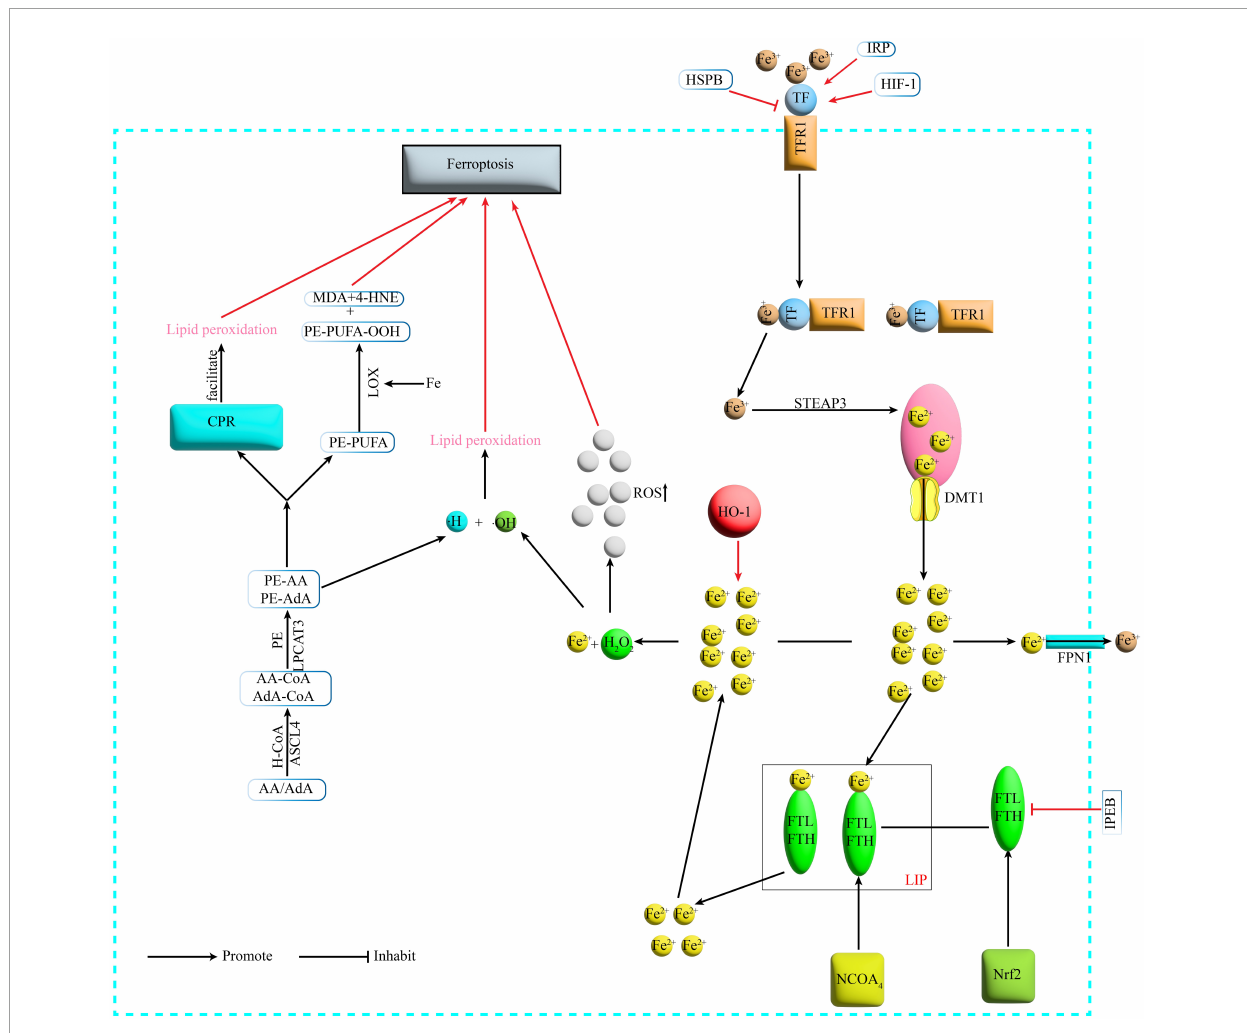
FIGURE1 Mechanism of Ferroptosis. Fe 3 + binds to TF on the cell membrane and is transported via TFR1 on the cell membrane surface, and the TFR1-TF-Fe 3 + complex enters the cell by endocytosis. Under acidic conditions, Fe 3 + is released from the binding and reduced by STEAP3 to Fe 2 + , which then enters the cytoplasm via DMT1 from the endosome. In the cytoplasm Fe 2 + is partly transported outside the cell and converted to Fe 3 + by FPN1, partly bound to ferritin to form LIP, and NCOA4 can recognize and rely on the autophagic pathway to degrade ferritin in the iron pool, releasing large amounts of Fe 2 + . TF, transferrin; TFR1, transferrin receptor1; STEAP3, six-transmembrane epithelial antigen of prostate 3; DMT1, divalent metal transporter 1; FPN1, membrane iron transporter 1; FPN1, ferroportin1; FTL, ferritin light chain; FTH, ferritin heavy chain; LIP, labile iron pool; NCOA4, nuclear receptor coactivator 4; H 2 O 2 , hydrogen peroxide; ACSL4, acyl-CoA synthetase long-chain family member 4; LPCAT3, lyso-phosphatidylcholine acyltransferase-3; LOX, lipoxygenase; MDA, malondialdehyde; 4-HNE, 4-hydroxynonenal; POR, cytochrome P450 oxidoreductase; IREB2, iron-responsive element-binding protein 2; HSPB1, heat shock protein beta-1; IRP, iron- regulatory protein; HIF-1, hypoxia-inducible factor-1; HO-1, heme